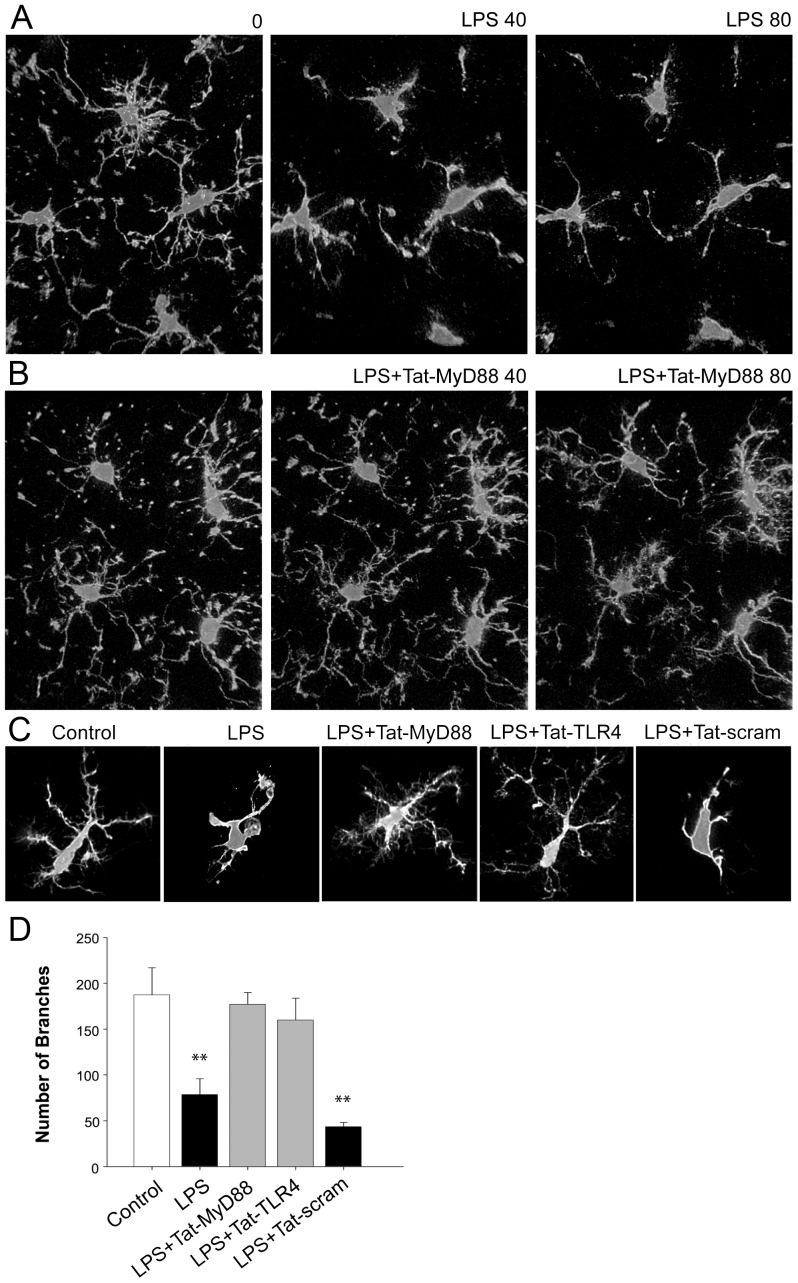
Time course of LPS-induced microglia morphology changes visualized using 2-photon imaging and the block by Tat-TLR4 and Tat-MyD88.A. Series of images at 0, 40 and 80 minutes following application of LPS showing the progression to amoeboid shape in microglia. B. Series of images at 0, 40 and 80 minutes showing Tat-MyD88 blocked the amoeboid shape change normally induced by LPS. C. Representative images of single microglia following individual treatments. D. Quantification of the number of branches of microglia following treatment.